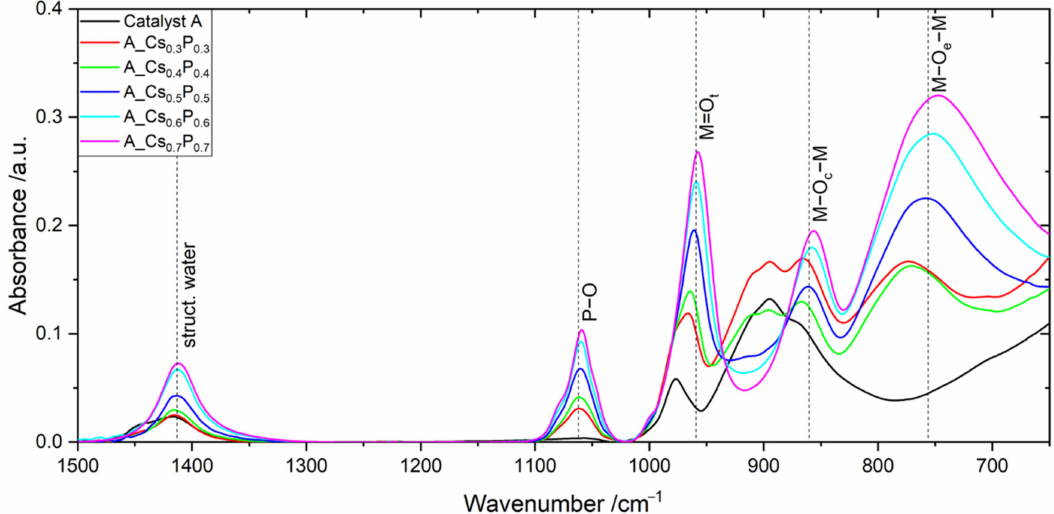
Figure 6. IR spectra of catalyst A prior to and after adding Cs and P with different (Mo + V + W)/P ratios at a constant Cs/P ratio of 1.